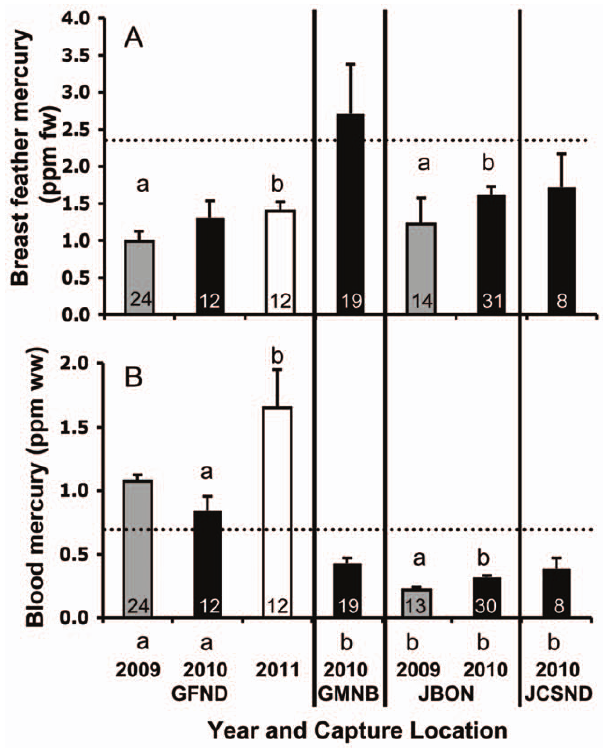
Figure 3. Temporal and geographic trends in breast feather and blood mercury. Mean mercury concentrations (error bars represent SD) for breeding Nelson’s Sparrow (A) breast feathers and (B) blood. Refer to Fig. 1 for capture location information. Gray bars represent data from 2009, black bars 2010, and white bars 2011. Numbers within each bar represent sample size. Lowercase letters above bars represent statistical differences among years within sites (proc glm, Tukey-Kramer multiple comparisons; P , 0.05). Lowercase letters below bars in (B) represent statistical differences in blood mercury among sites within years (proc glm, Tukey-Kramer multiple comparisons; P , 0.05). Dashed lines represent negative effects thresh- olds – tissue concentrations associated with a 10% reduction in nest